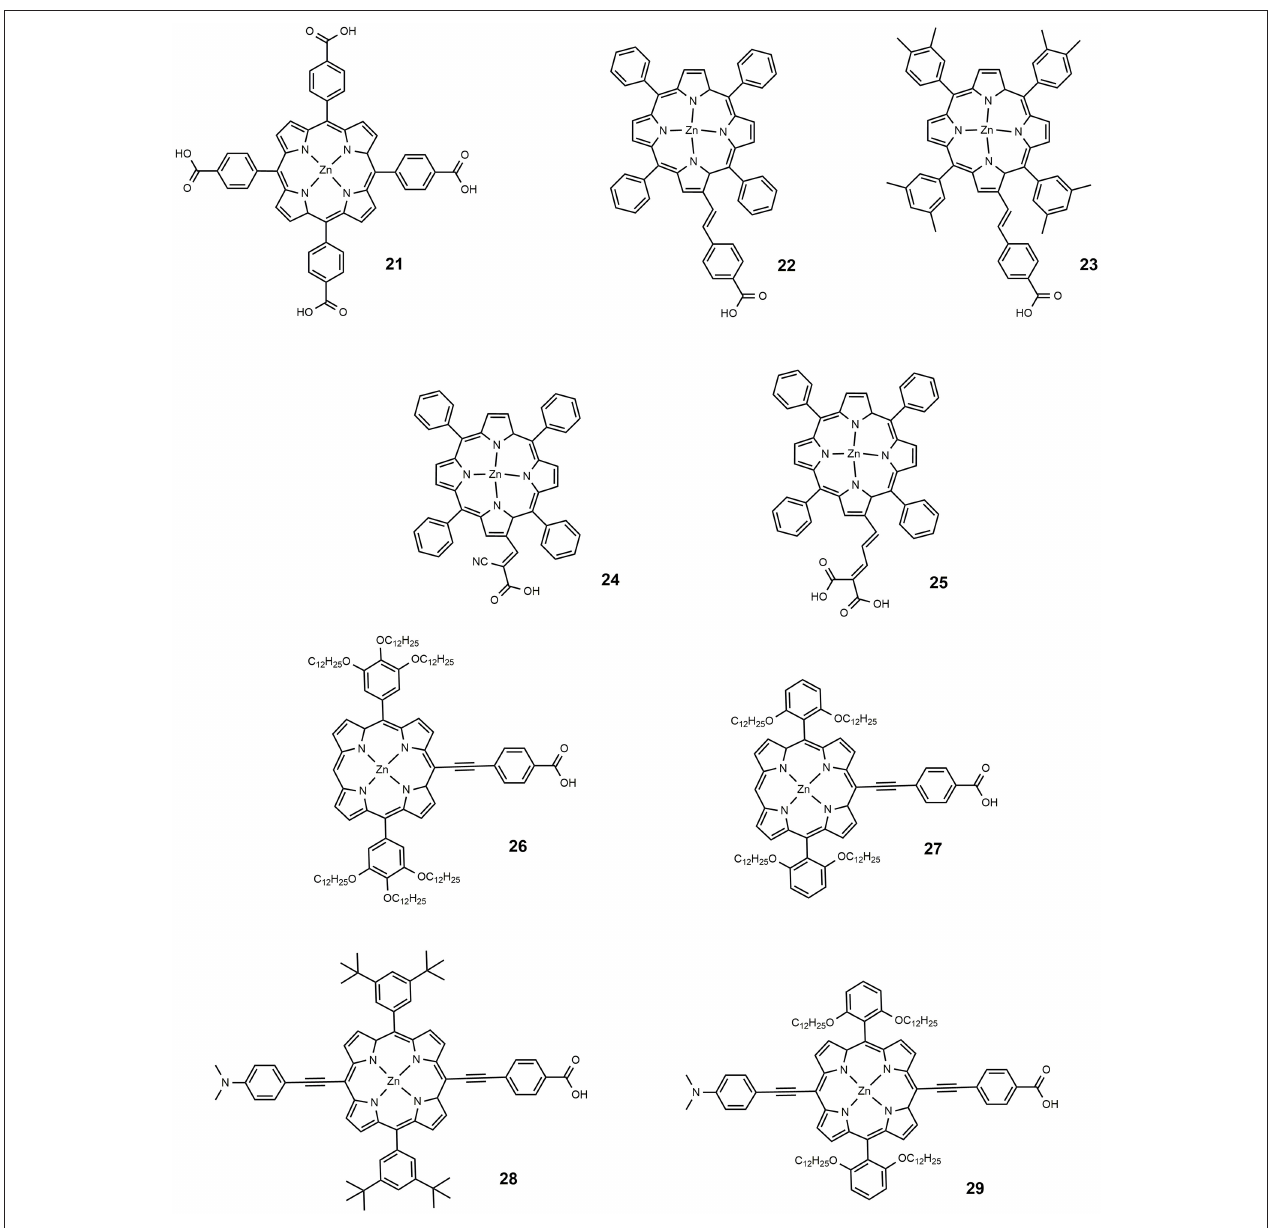
FIGURE 4 | Chemical structure of dyes 21–29.